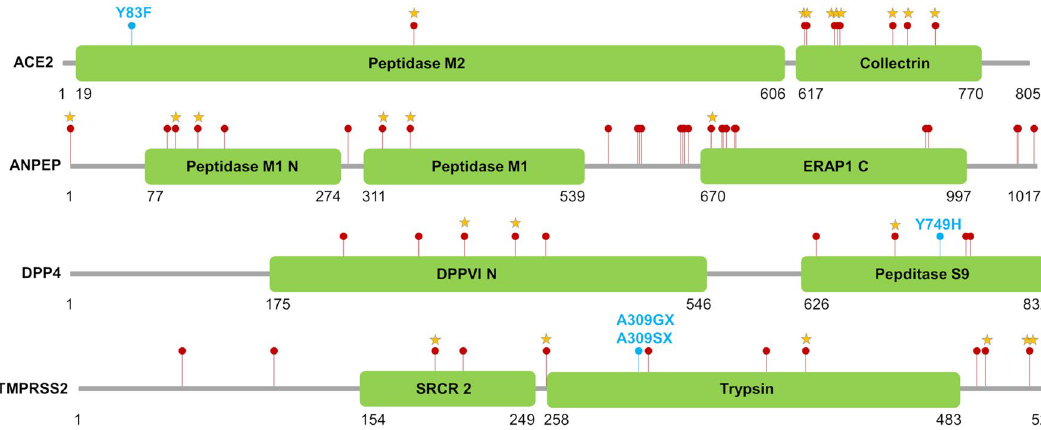
Figure 3. Protein coding variants affecting the ACE2, ANPEP, DPP4 and TMPRSS2 proteins. Red dots indicate the variants retrieved from Ensembl database. Light blue dots and stars indicate novel and known variants identified from the resequencing datasets, respectively. Protein domains and their coordinates are based on the Pfam database (https ://pfam.xfam.org/) considering the protein identifiers provided in Table (Fig. 3). The P519 allele was also affected by a second missense variation (rs789944785). A manual inspec- tion of sequenced reads highlighted that these two variants (rs789572246 and rs789944785) were not in complete linkage disequilibrium. Two other novel frameshift mutations (13:g.204881920_20488192insT and 13:g.204881920_20488192insG) would completely change the peptidase coding region of the canonical gene transcript. However, considering an alternative transcript for this gene (transcript ENSSSCT00000026685.3; Uni- ProtKB I3LBF8), these two variants would be annotated as splice donors (as they might change the 2 nd base pair region at the 5 ′ -end of an intron). It is worth to mention that at this position, the reference allele was not found in any resequencing dataset in which, instead, all three genotypes insG/insG, insG/insT and insT/insT were called. Mining whole genome resequencing data retrieved from the Chinese Meishan breed and from Asian wild boars identified other four variants affecting protein sequences (DPP4: p.I383V and p.S704L; ANPEP: p.V32A and p.E359D). Considering also the other variants described above for the European breeds and wild boars, a total of 15 and 14 variants affecting proteins were identified in the Chinese Meishan breed and in the Asian wild boars, respectively (Table 2 and Fig. 4). Putative functional effects of the porcine protein variants. For a comprehensive analysis of the effects of protein coding variants in the four analysed genes, the 29 variants affecting proteins and identified in the European pig breeds and wild boars and in the Asian pig populations (described above) were combined with information on polymorphic sites available in the Ensembl database for the same genes. The Ensembl database reported a total of 60 functional coding variants (10 in the ACE2 gene, 28 in the ANPEP gene, 9 in the DPP4 gene and 13 in the TMPRSS2 gene) that combined with the mentioned variants accounted for a total of 64 variants affecting the protein encoded by the four genes (11 in the ACE2 gene, 28 in the ANPEP gene, 10 in the DPP 4 gene and 15 in the TMPRSS2 gene; Supplementary Table S9). Figure 3 shows the position of all these variants. Of the 11 ACE2 protein coding variants, p.P738L was the only one predicted to be deleterious (low confi- dence). Variants affecting the residues p.N653, p.S657 and p.A658 were located in a protein region interacting with the ADAM17 sheddase whereas variants of the residues p.K702 and p.R716 belong to a domain interacting with the serine proteases TMPRSS1 and TMPRSS2 (Supplementary Table S4). The novel variant p.Y83F detected only in a few European pig breeds (i.e. Gascon, Basque and Bísara) is located within a protein region (human M82-Y83-P84) suggested to participate in SARS-CoV-2 S-protein association 34 . Of the 27 ANPEP protein coding variants, 22 were classified as tolerated, four were classified as deleterious and one was a frameshift variant (rs431825257) at the C-terminal end of the protein. Based on annotations com- ing from the human ANPEP protein, none of these SAPs affected sites were relevant for the virus-host interac- tion or for the functional activity of the protein (Supplementary Table S5). Porcine variants p.M663V, p.F645S, p.A647V and p.R651Q were located in a protein region not homologous to the human protein (i.e. they were included in an alignment gap). Two out of ten DPP4 protein coding variants were predicted to be deleterious whereas the other seven missense mutations were classified as tolerated. A stop gained variant that eliminates 60 amino acids of the C-terminal end was also identified among the annotated variants in Ensembl. Key sites identified in the compara- tive analysis did not overlap with any of these variants (Supplementary Table S6). However, the variants p.I383V (p.L316 Human ) and p.A409V (p.A342 Human ) were close to the p.R317 Human , p.R336 Human , p.I346 Human and p.Q344 Human residues that constitute the MERS-CoV receptor-binding domain (Supplementary Table S7; 84 ). variant p.I258V (p.I256 Human , Supplementary Table S6) may affect the proteolytic cleavage site (human R255-I256 bond), where auto-cleavage of TMPRSS2 occurs at p.R255 resulting in the release of the active protease 85 .